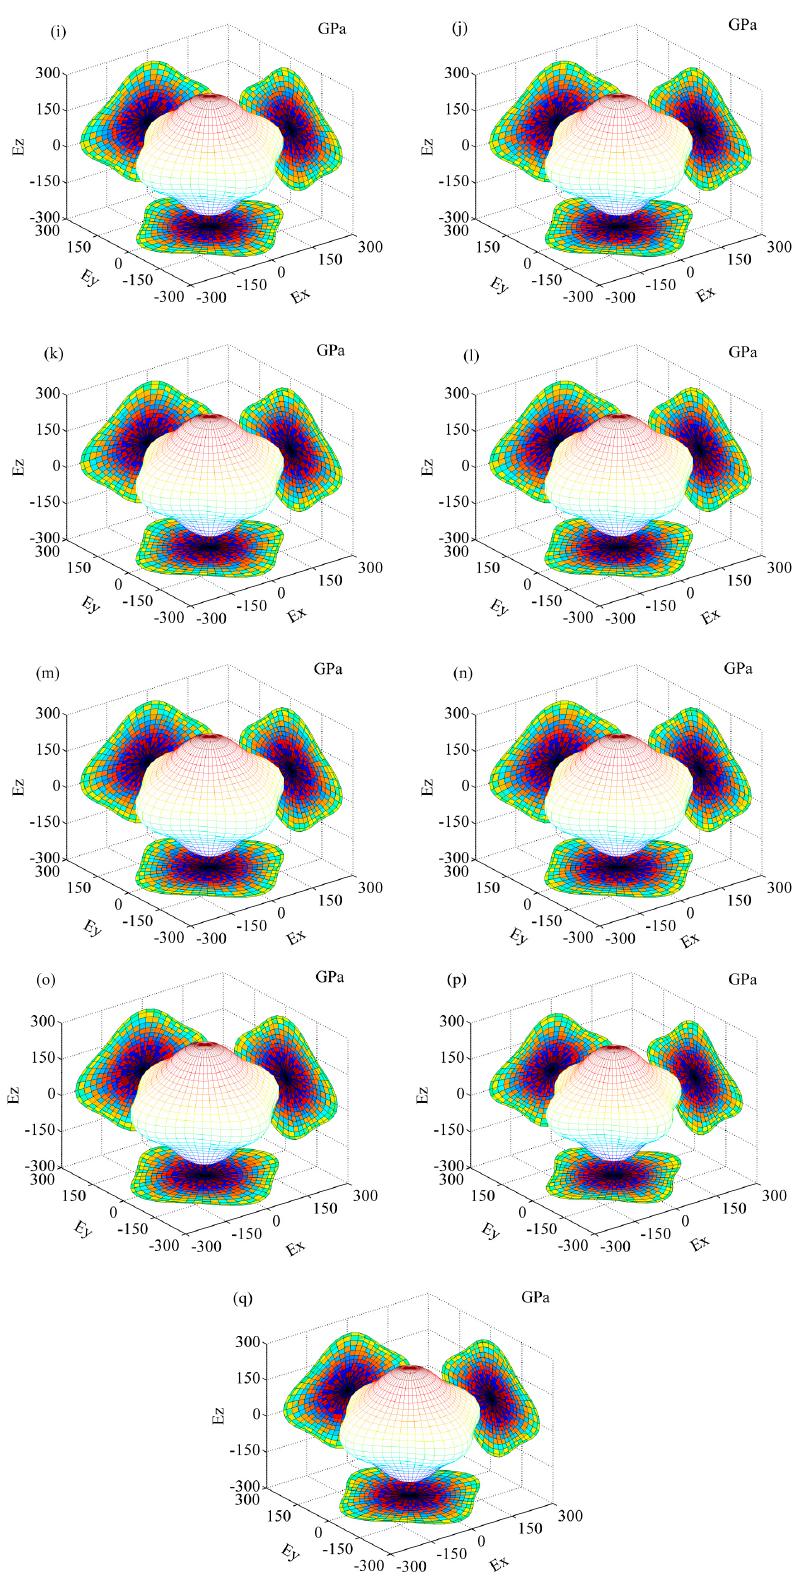
Figure 2. The 3D curved surface of the Young’s modulus of Al 8 Fe 4 RE IMCs. ( a ) Al 8 Fe 4 Sc; ( b ) Al 8 Fe 4 Y; ( c ) Al 8 Fe 4 La; ( d ) Al 8 Fe 4 Ce; ( e ) Al 8 Fe 4 Pr; ( f ) Al 8 Fe 4 Nd; ( g ) Al 8 Fe 4 Pm; ( h ) Al 8 Fe 4 Sm; ( i ) Al 8 Fe 4